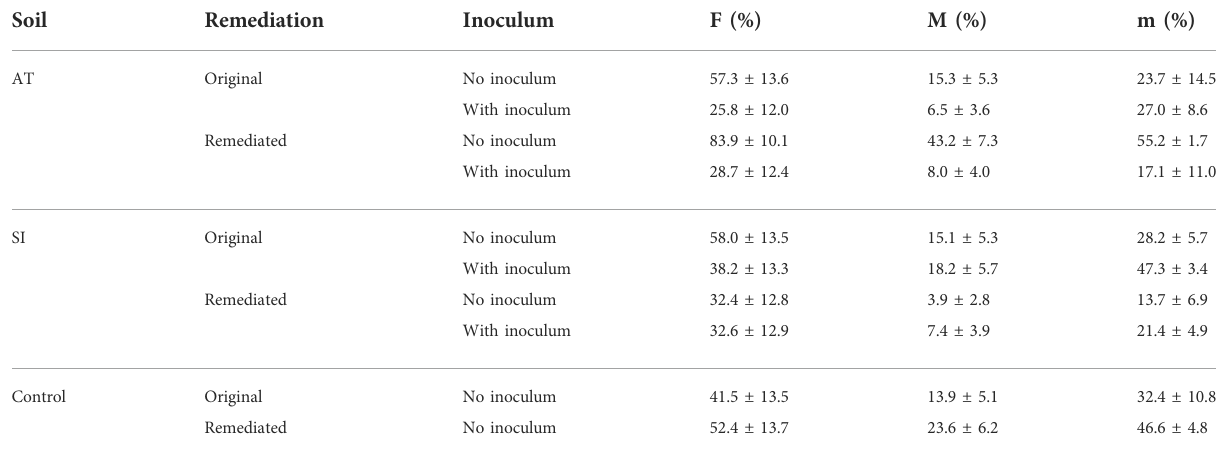
TABLE2Linearmodelestimatesofmean±SEAMfungalrootcolonisation(sampledon17November2017)calculatedasfrequencyofmycorrhization (F), intensity of root cortex colonisation (M) and intensity of colonisation within individual mycorrhizal roots (m).